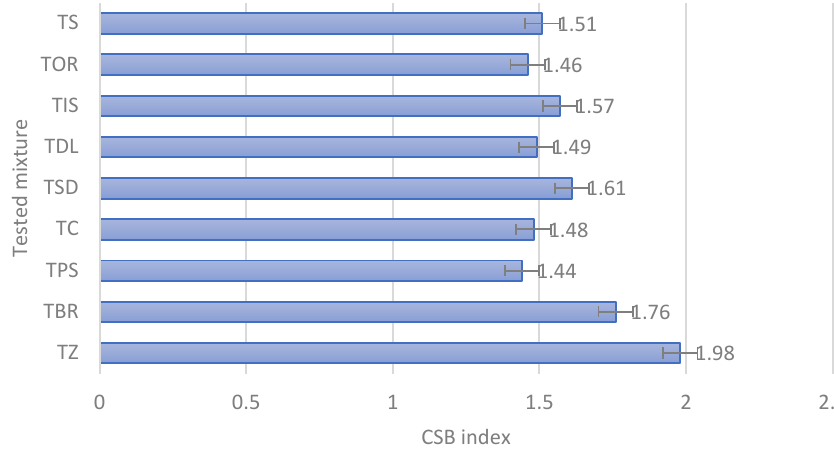
Figure 9. Drying linear shrinkage and Bending strength of the dried samples.